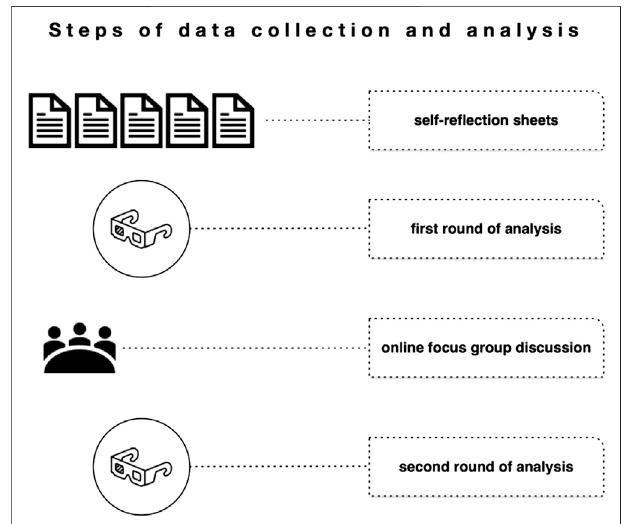
FIGURE 2 | Steps of data collection and